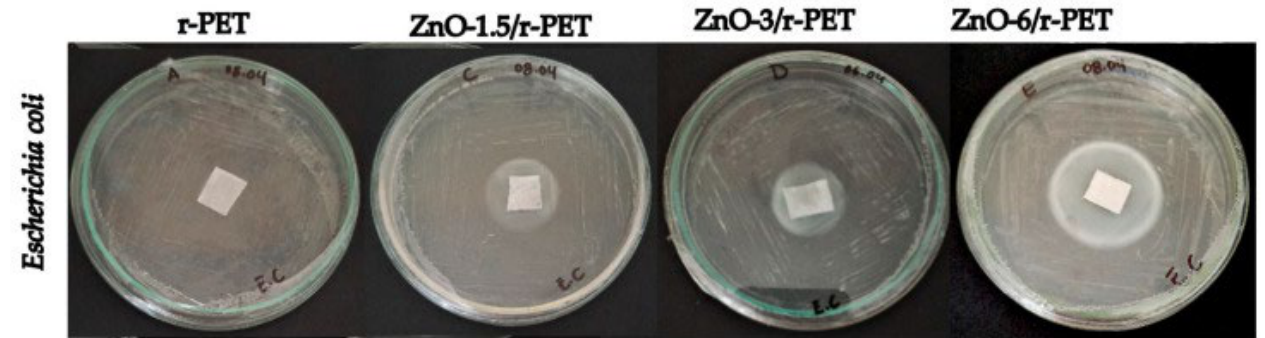
Figure 10. Antibacterial tests Bacillus subtilis in polymer composite fibers [107] .